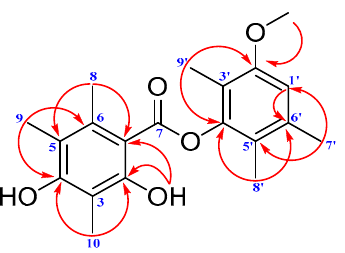
Figure 5. Key HMBC (arrows) correlations of 2 .